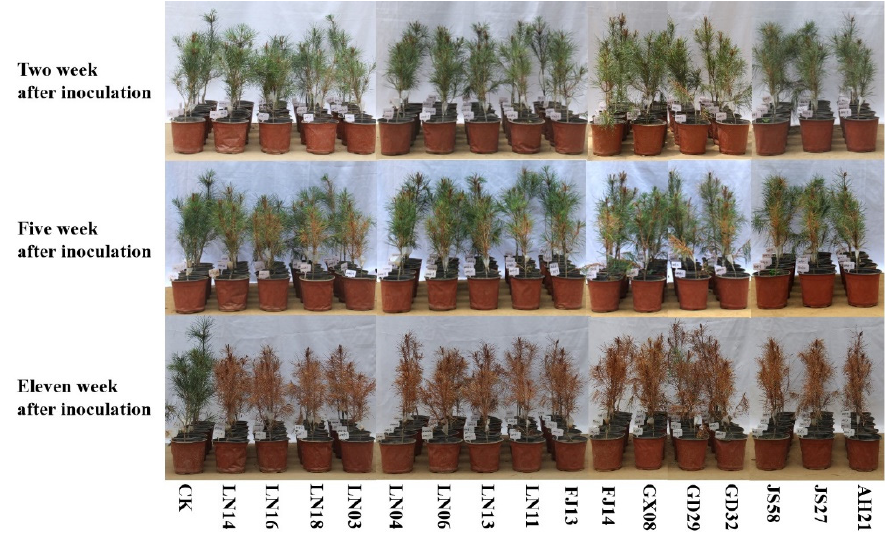
Figure 4. The pine wood nematode (PWN) Bursaphelenchus xylophilus disease index in P. thunbergii after inoculation with PWN strains. Sixteen reference numbers represent sixteen PWN isolates from different regions. ( A ) Disease index of the 8 northern strains. ( B ) Disease index of the 8 southern strains.